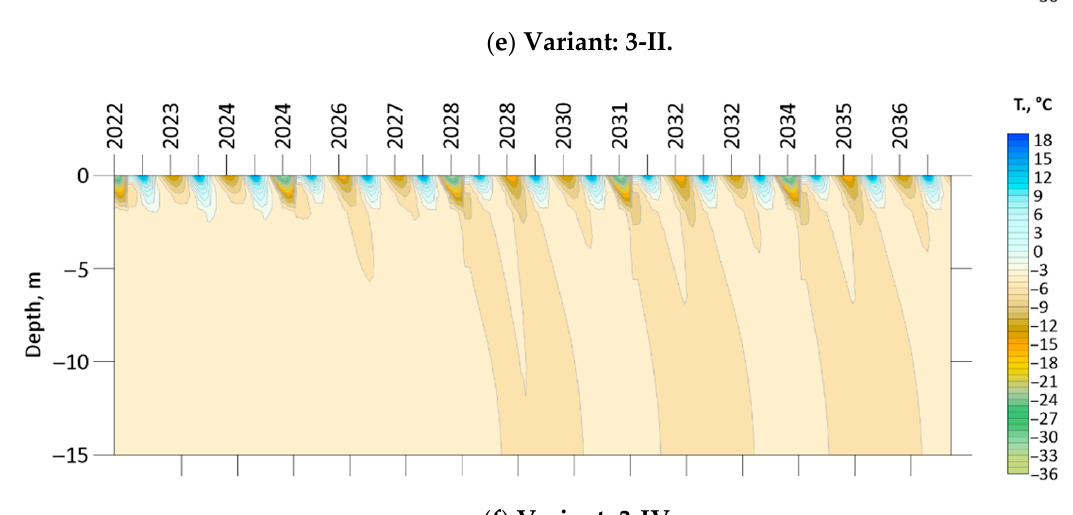
Figure 6. Mean annual dynamics permafrost temperature in 2022 and 2036 under the considered variants and scenarios.